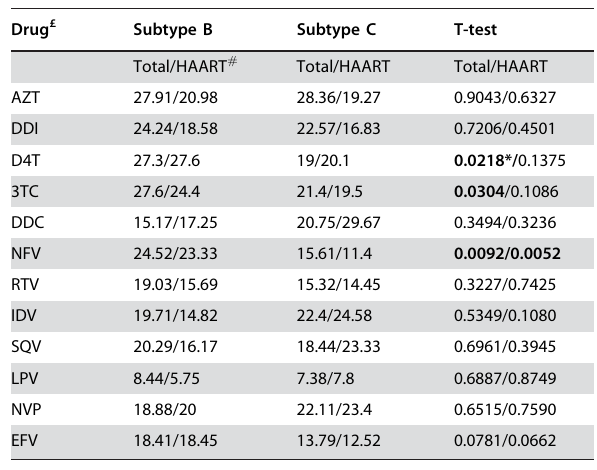
Table 3. Mean time of drug exposure in months for each